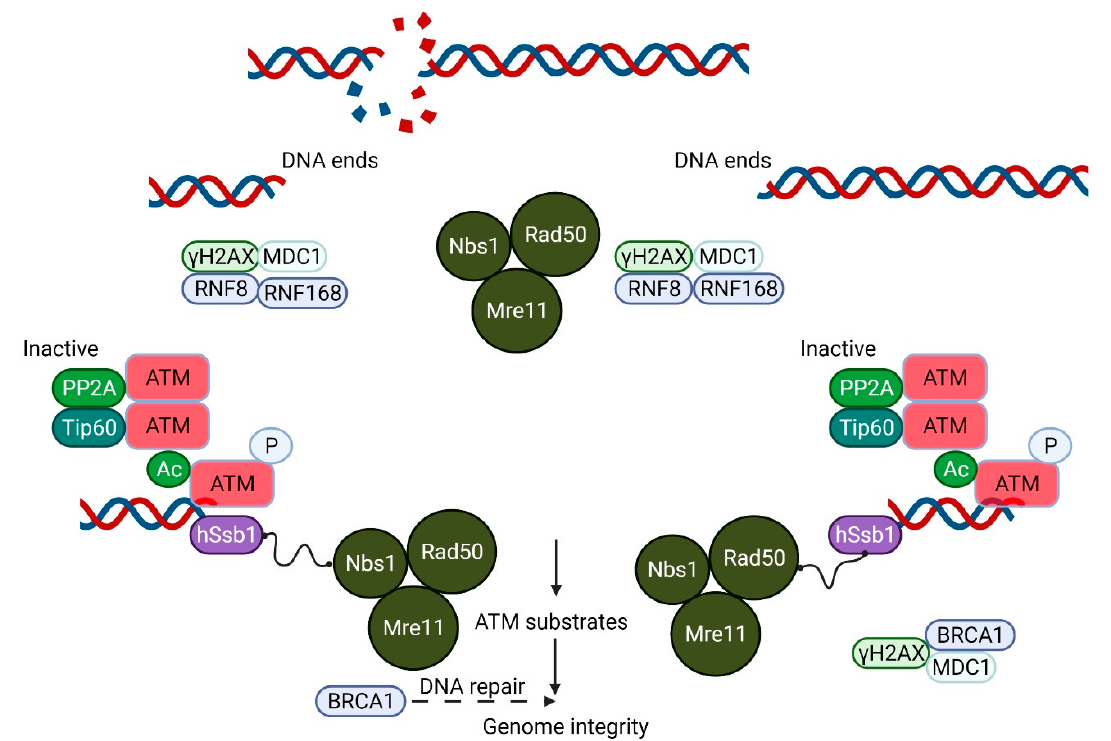
Figure 1. A Schematic model showing the essential role of ATM in DNA double-strand break (DSB) repair. The Mre11/Rad50/Nbs1 (MRN) complex plays an important role in DSB recognition and signaling ATM. ATM, which exists as an inactive dimer under normal conditions, becomes activated as a monomer in response to MRN signaling. This MRN-mediated activation of ATM stimulates the kinase activity of ATM, which phosphorylates p53, Chk2 and other substrates, including Brca1, which together play a crucial role in the maintenance of the genomic integrity of the cell.